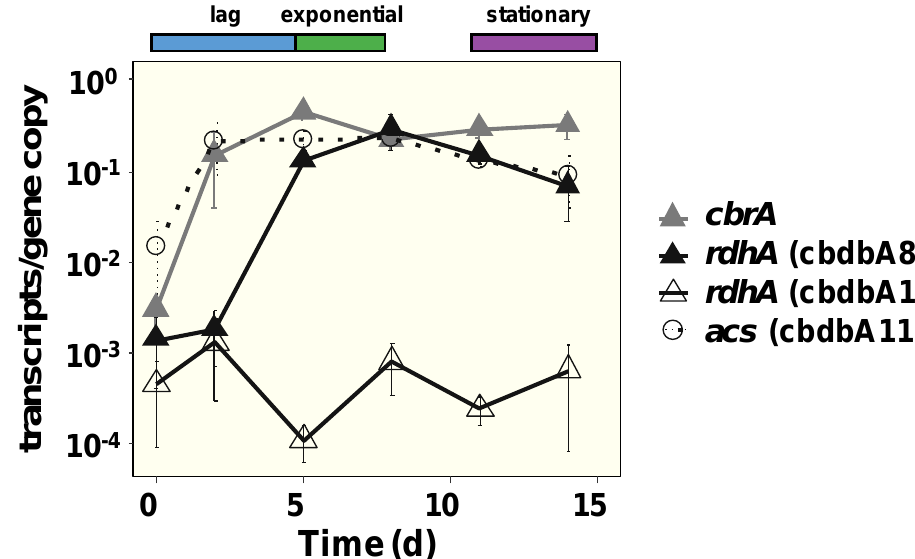
Figure 4. Transcription of rdhA genes cbrA , cbdbA80, and cbdbA1588, as well as of the gene cbdbA1126 encoding the acetyl-CoA synthetase of D. mccartyi strain CBDB1 was analyzed in the cultures shown in Figure S3, curve III. The respective ranges of the lag, exponential, and stationary phases are indicated. Mean values and standard deviations of three replicates are shown.